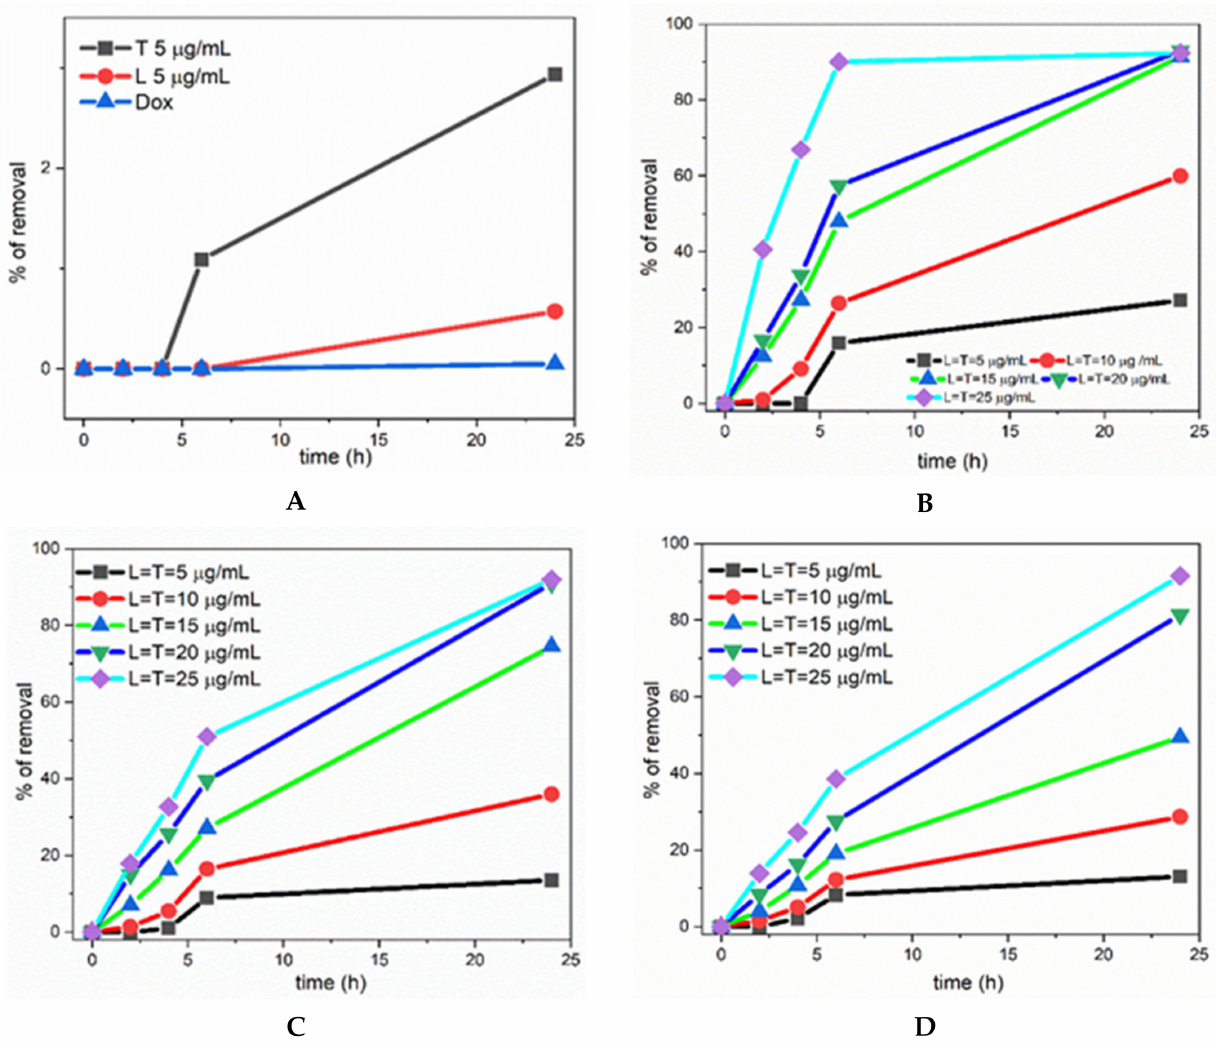
Figure 3. Percentage of removal of doxorubicin at pH 5: ( A ) blue, plain doxorubicin; red, in the presence of laccase; black, in the presence of TEMPO; ( B – D ) with the simultaneous presence of the laccase enzyme (L) and TEMPO (T) free radical. Starting doxorubicin concentrations: ( A ) 75 mg/mL; ( B ) 25 mg/mL; ( C ) 50 mg/mL; ( D ) 75